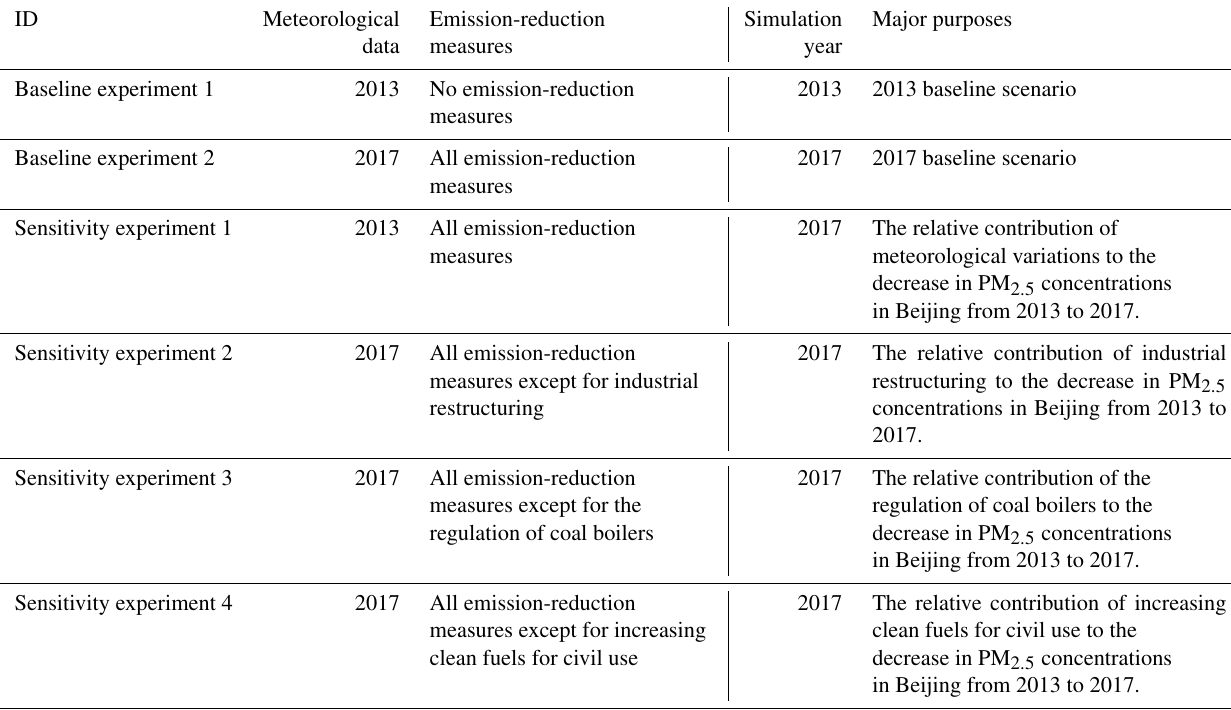
Table 3. The design and materials for two baseline and four sensitivity experiments using